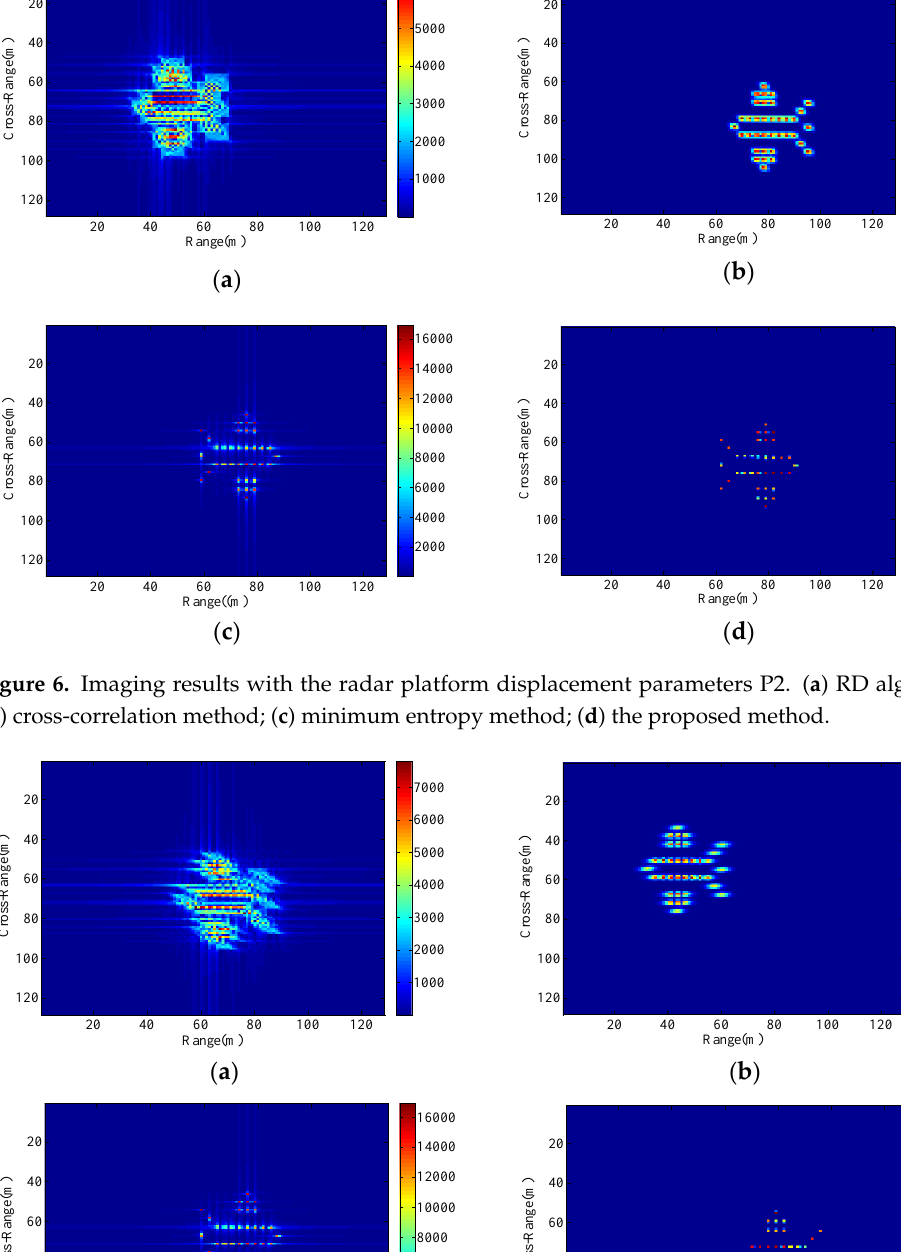
Figure 5. Imaging results with the radar platform displacement parameters P1. ( a ) RD algorithm; ( b ) the proposed method.